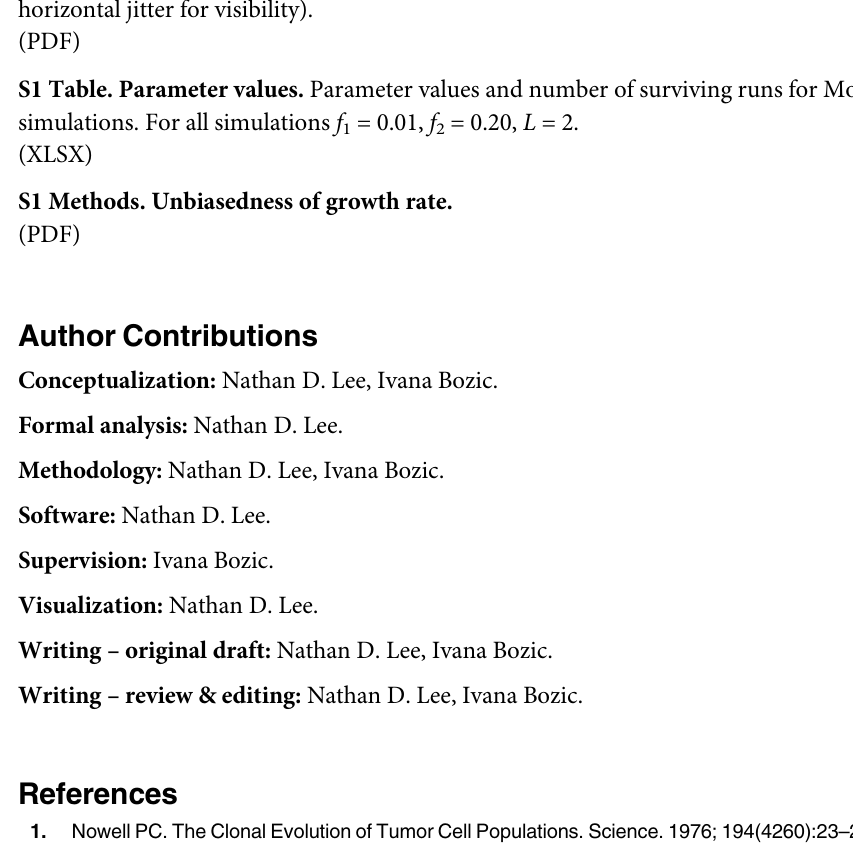
S5 Fig. Accuracy for t estimate increases with tumor size. A Monte Carlo simulation of a birth-death process was performed for (a) fast-growing, (b) slow-growing, and (c) no cell death parameter regimes. For each of the 100 surviving simulated tumors, the percent error of the t estimate (Eq (3)) was calculated when the tumor first reached the specified tumor sizes. Means are indicated by red points and lines, ± one standard deviation is shown by the red region, and individual data points for each simulation run are shown as the grey points (with horizontal jitter for visibility). S1 Table. Parameter values. Parameter values and number of surviving runs for Monte